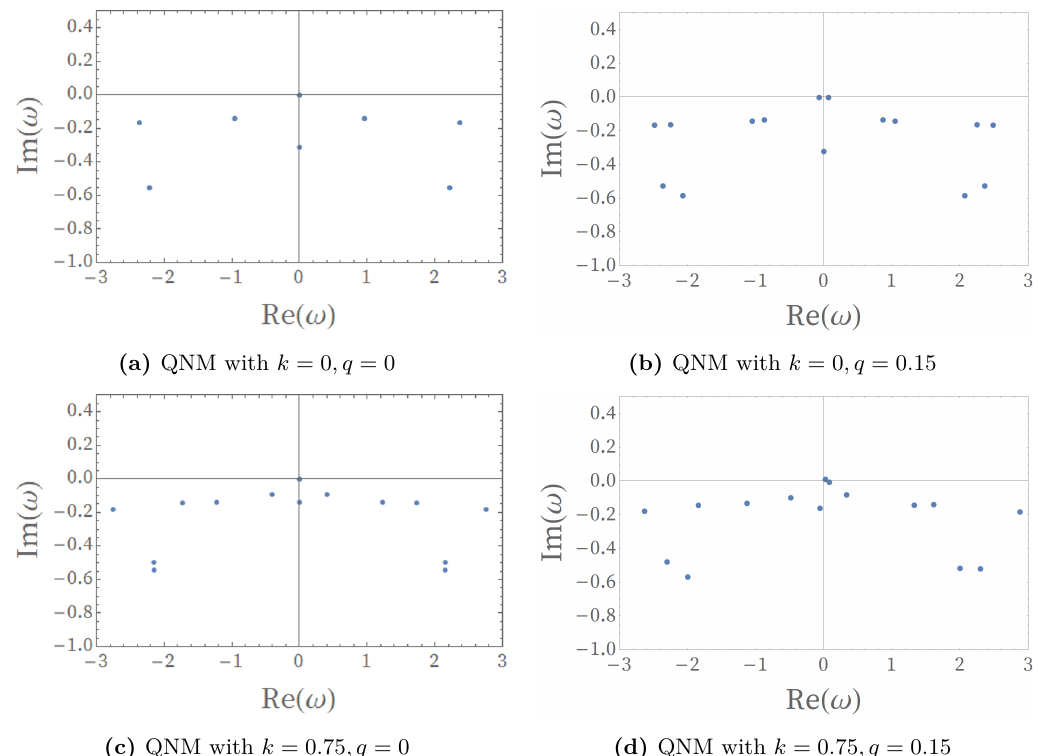
Figure 3. 3a and 3b show the QNM corresponding to ψ ’s Bloch wave vector k = 0 and wave vectors of the perturbed field q = 0 (left) and q = 0 . 15 (right), respectively; 3c and 3d show the QNM corresponding to ψ ’s Bloch wave vector k = 0 . 75 and wave vectors of the perturbed field q = 0 (left) and q = 0 . 15 (right), respectively. Actually, the QNM is symmetric under Re( ω ) → − Re( ω ) when q=0 and we confirm this in appendix A.